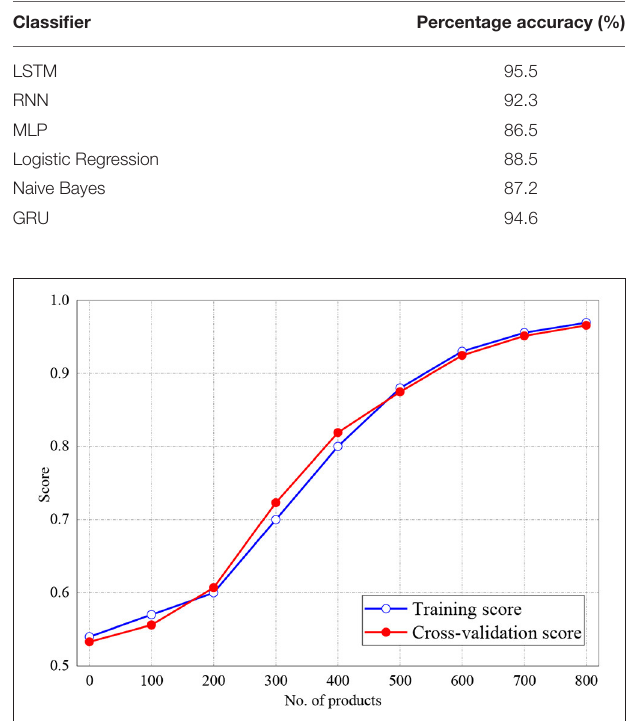
FIGURE 3 | Result for Training and Cross-Validation of Naive Bayes classifier.